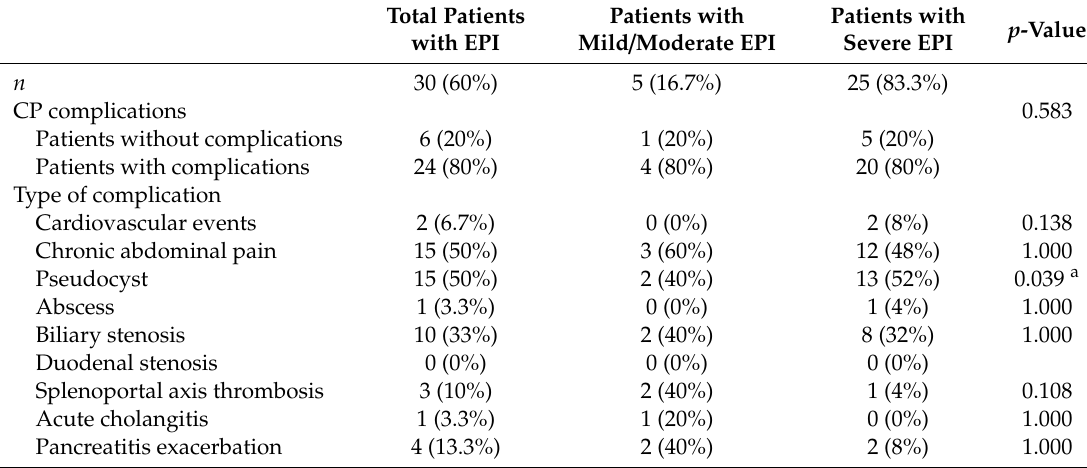
Table 9. Complications of chronic pancreatitis in patients with mild / moderate and severe EPI. ( n = 30).